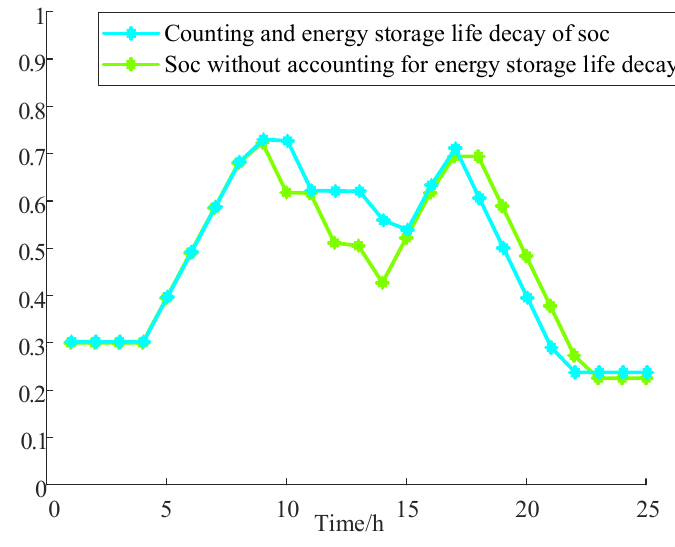
Figure 7. SOC comparison of two cases.